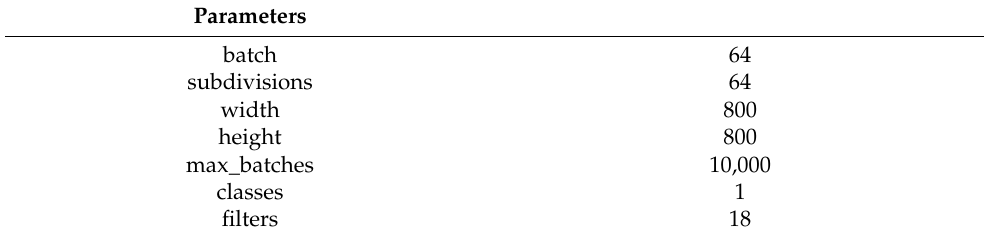
Table 3. The parameters of the YOLO v4 algorithm in this study.